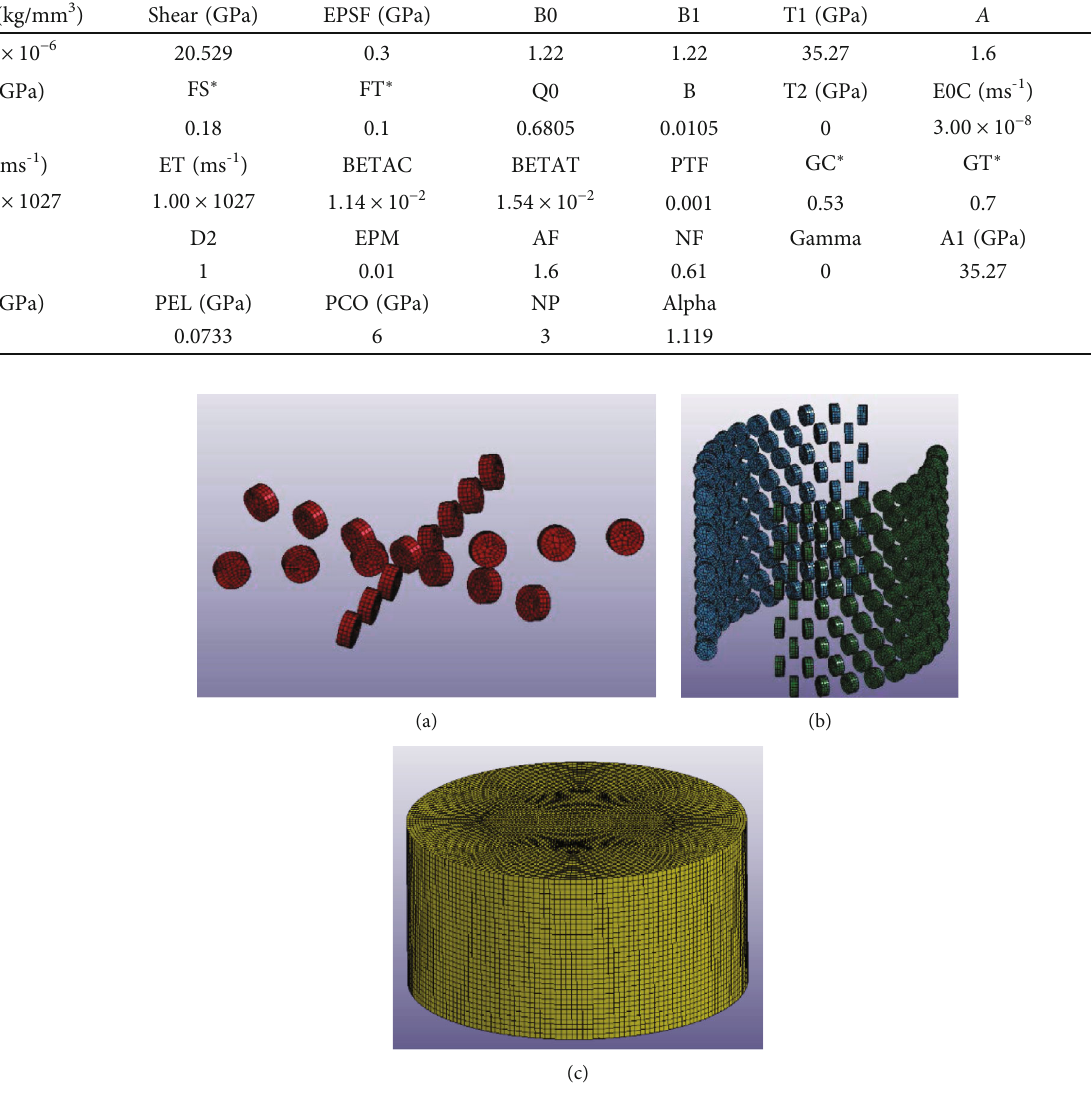
Figure 7: (a) PDC teeth on bottom cutter. (b) PDC teeth on bionic blades. (c) Rock. Table 4: Cutting process of the bionic lateral PDC reamer